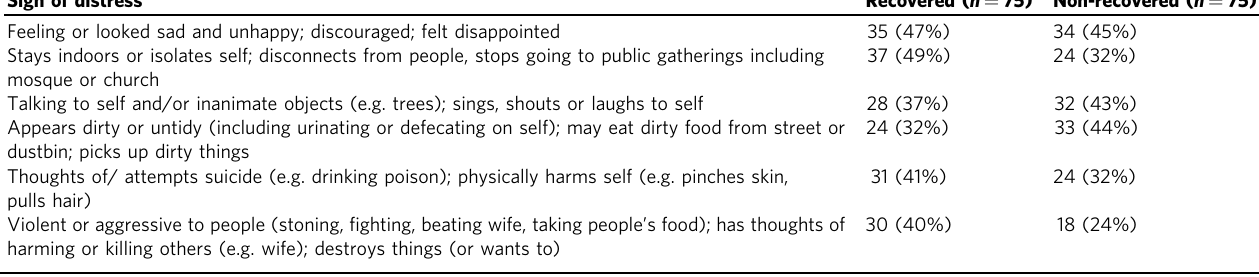
Table 3 Most frequent six signs of distress.